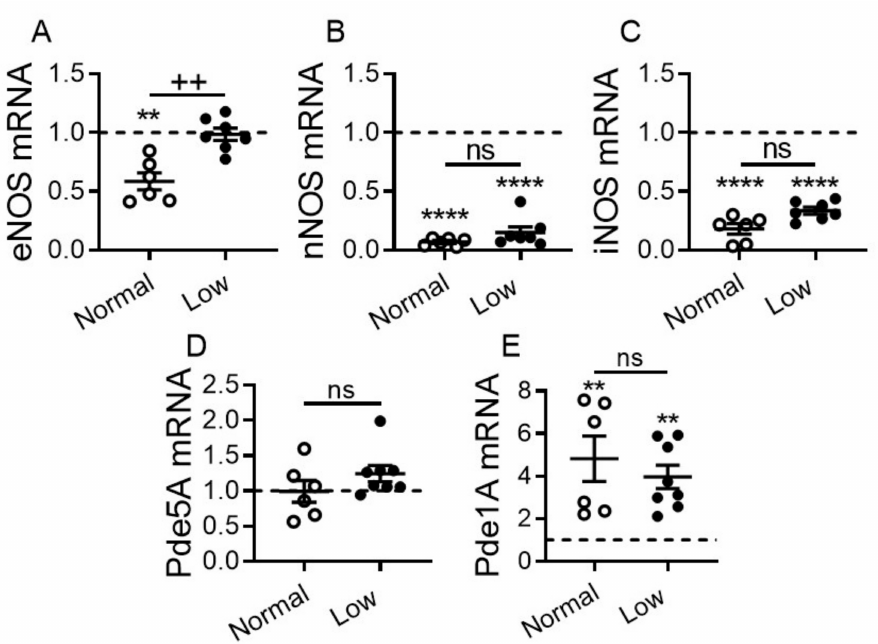
Figure 8. Effect of dietary sodium restriction on cardiac expression of nitric oxide synthases (NOS) and phosphodiesterases (Pde) in mice with DCM. Cardiac transcript levels of ( A ) eNOS, ( B ) nNOS, ( C ) iNOS, ( D ) Pde5A, and ( E ) Pde1A. Number of DCM mice n = 6–8 per group. WT control mice (dashed line, n = 5–6). Data are presented as mean ± SEM. **** p < 0.0001, ** p < 0.01 (DCM vs. WT), ++ p < 0.01 (LSD vs. NSD), ns = non-significant. Data were analyzed by one-way ANOVA with Newman–Keuls multiple comparison